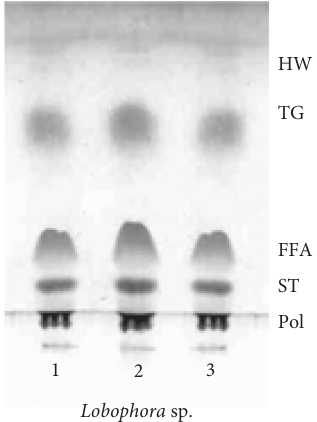
Figure 1: TLC for determination of total lipid. Table 1: Five main classes (% of total lipid) of Lobophora sp. Lipid class Content (%) Hydrocarbon and wax (HW)